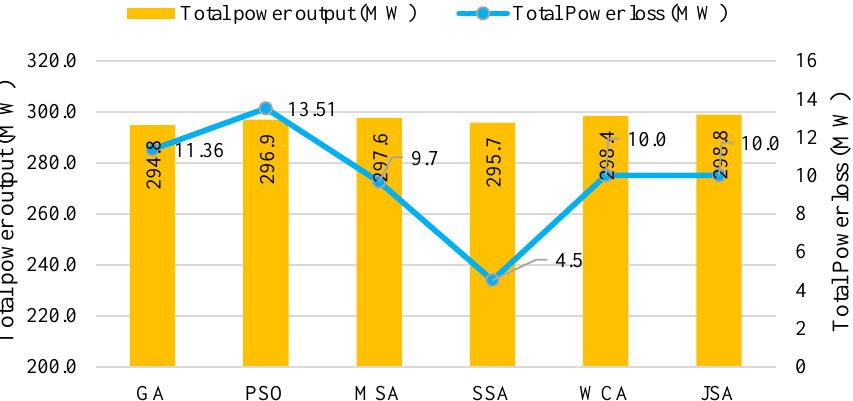
Figure 7. Total generation of all thermal units obtained by algorithms for Case 1.